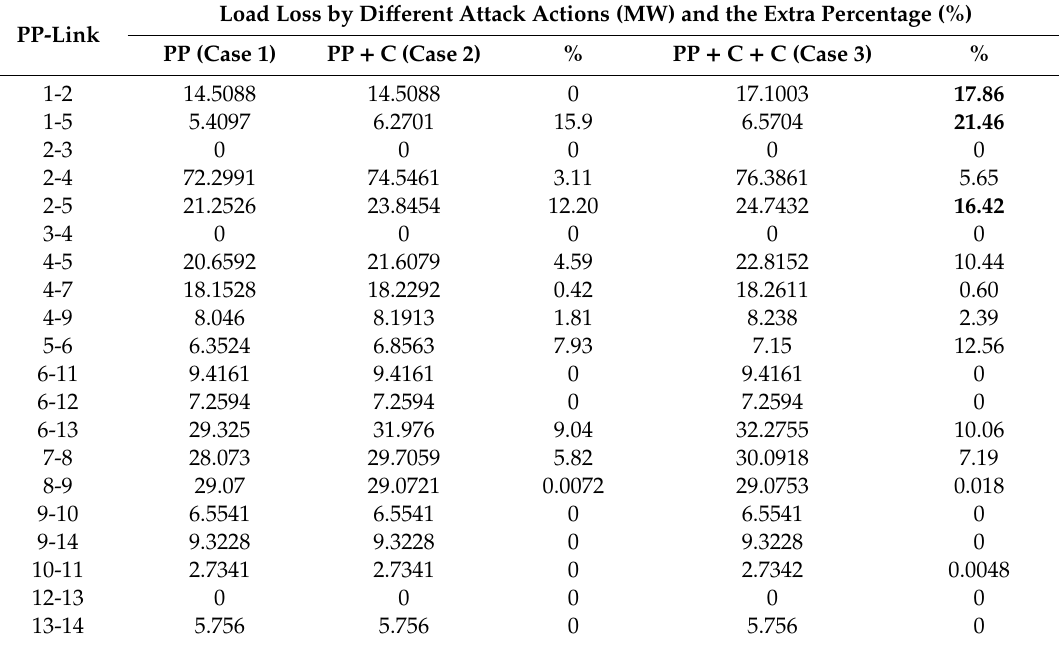
Table 1. Load loss under di ff erent attack scenarios assuming no defense to attacks. PP-Link